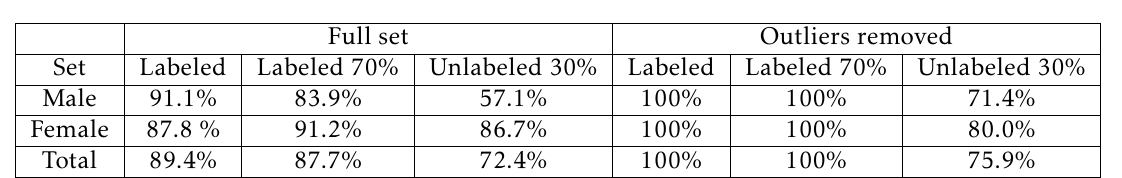
Table 2. Accuracy of predicted results. Labeled set refers to the full data set used in Section 4.1. Labeled 70% and unlabeled 30% refer to the training set and test set used in Section 4.2,